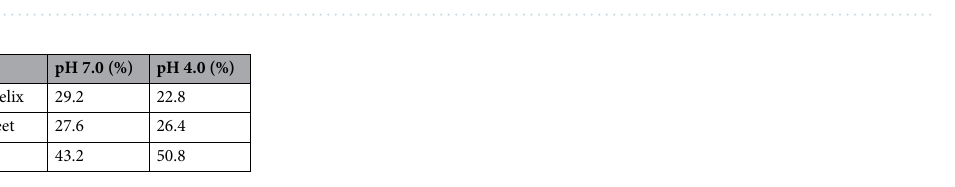
Figure 2. hPrdx6’s structural characterization. To determine the structure of hPrdx6 at pH 7.0 and 4.0, the ( A ) Far-UV CD, ( B ) Near-UV CD, ( C ) Tryptophan fluorescence and ( D ) ANS binding assay measurements are done.